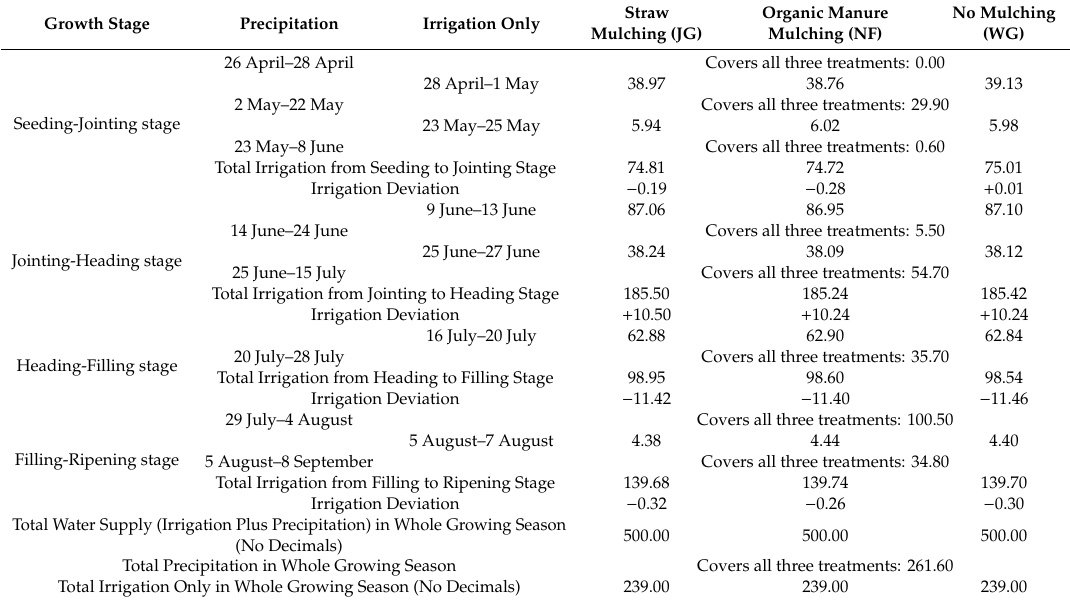
Table 1. The irrigation regimes across the growing season (mm, April–September